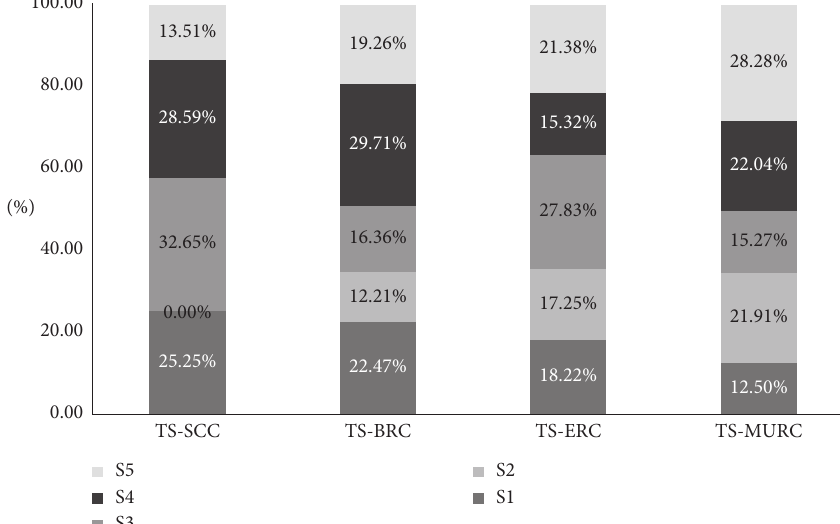
Figure 8: Inventory proportion of the temporary storage